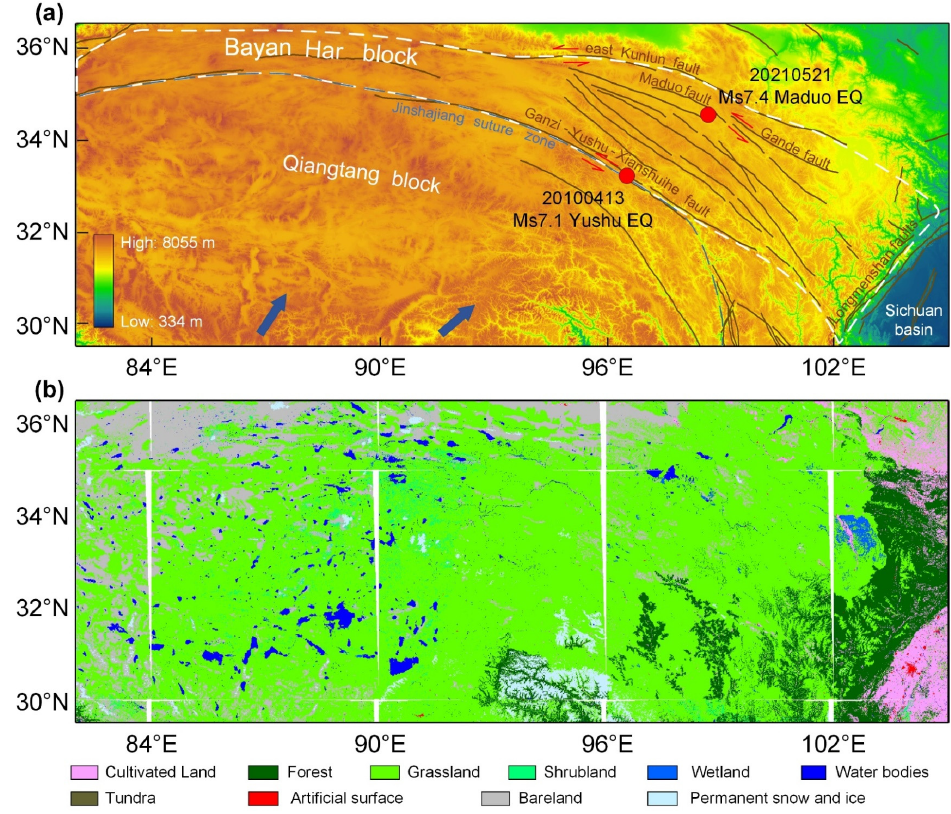
Figure 1. Distributions of surface elevation ( a ) and landcover ( b ) in the study area.